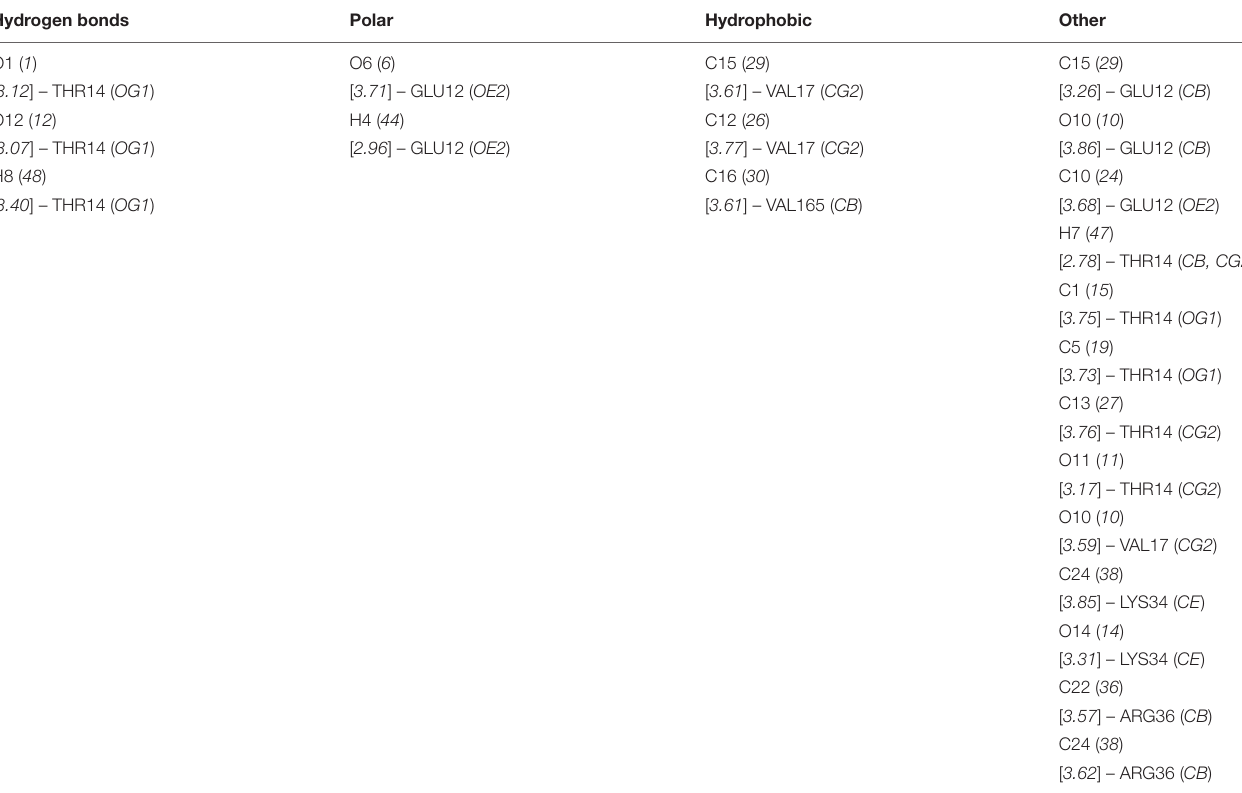
Frontiers in Plant Science |